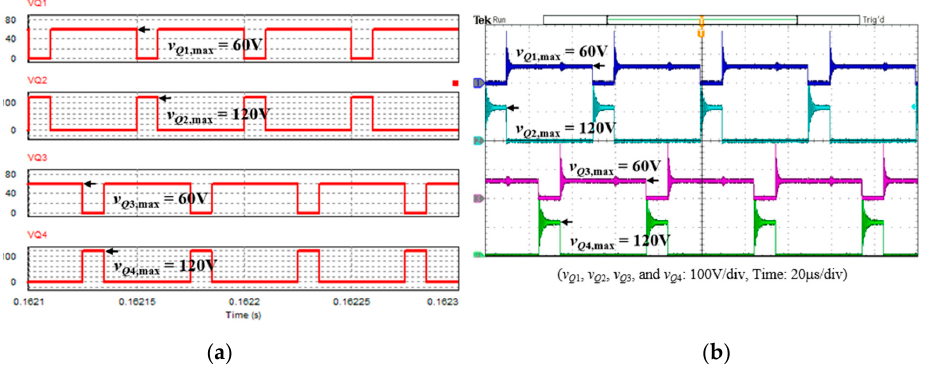
Figure 19. The waveform of the secondary-side currents of the coupled inductor and DC-bus voltage in the UC discharging mode with D d = 0.2: ( a ) simulated and ( b ) experimental.